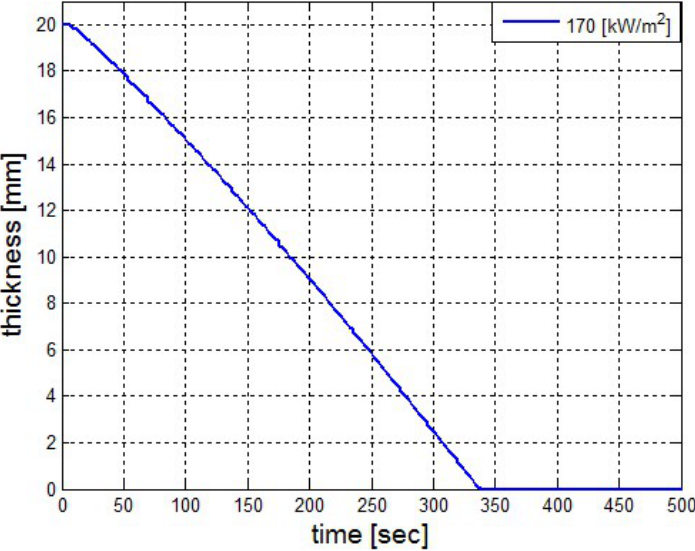
Figure 11. Predicted thickness of the composite as a function of time for heat flux of 170 kW/m².